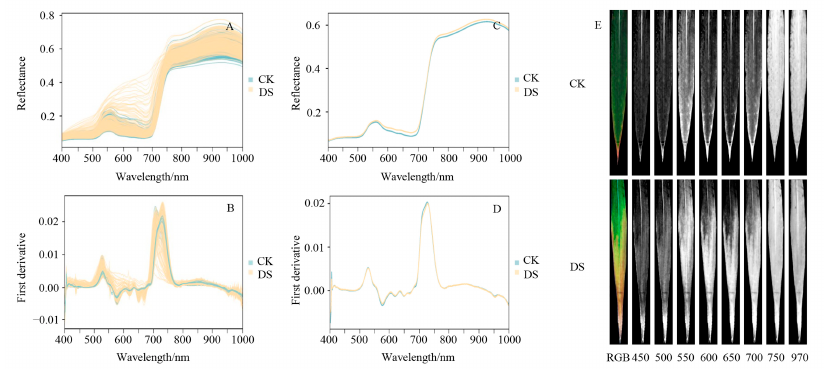
Figure 2. Hyperspectral curves and single-band hyperspectral images of wheat leaves under differ- ent soil moisture conditions. Hyperspectral reflectance and first derivative curves of leaves from 335 wheat varieties under control (CK) and drought stress (DS) conditions; ( A , B ) hyperspectral reflectance curves of leaves and first derivative values; ( C , D ) mean hyperspectral reflectance curves of leaves and first derivative values; ( E ) single-band hyperspectral images; hyperspectral band region (400–1000 nm); hyperspectral images obtained using the Pika L hyperspectral imaging system; RGB images (red = 640 nm, green = 550 nm, blue = 460